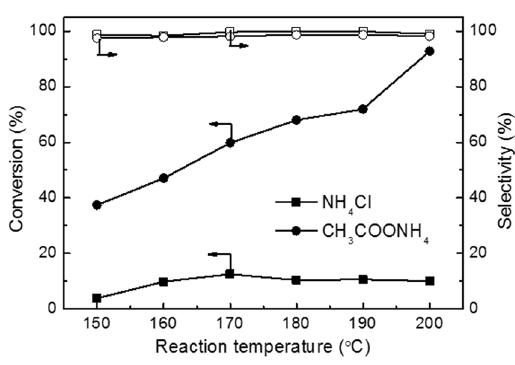
Figure 6. Effect of temperature on ammonia conversion and N 2 selectivity of NH 4 Cl and CH 3 COONH 4 solutions over Ru-Cu/C catalyst. Conditions: [NH 4 + ] 0 = 1000 ppm, pH = 8.2, Air pressure = 2 MPa, reaction time = 3